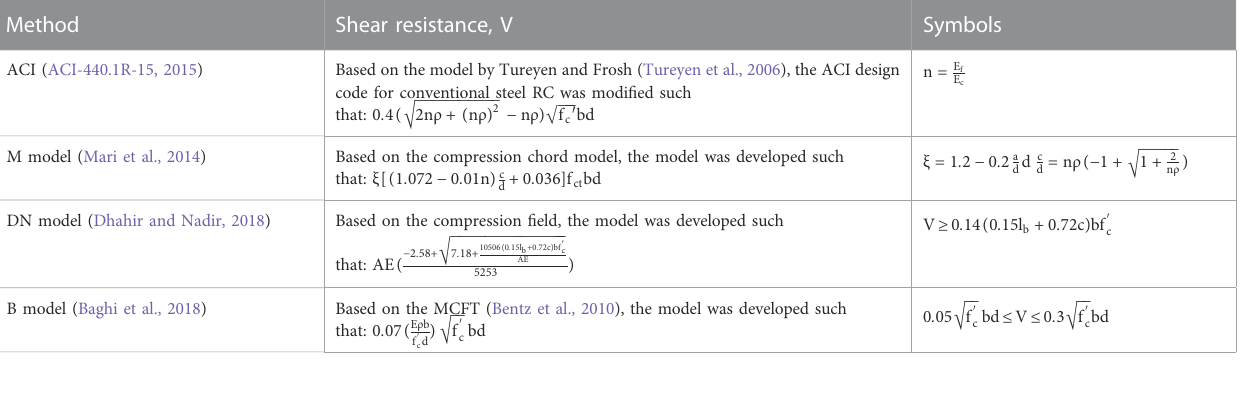
TABLE 2 Summary of selected model and design codes.